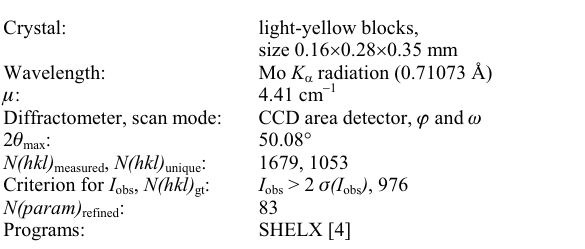
Table 1. Data collection and handling.